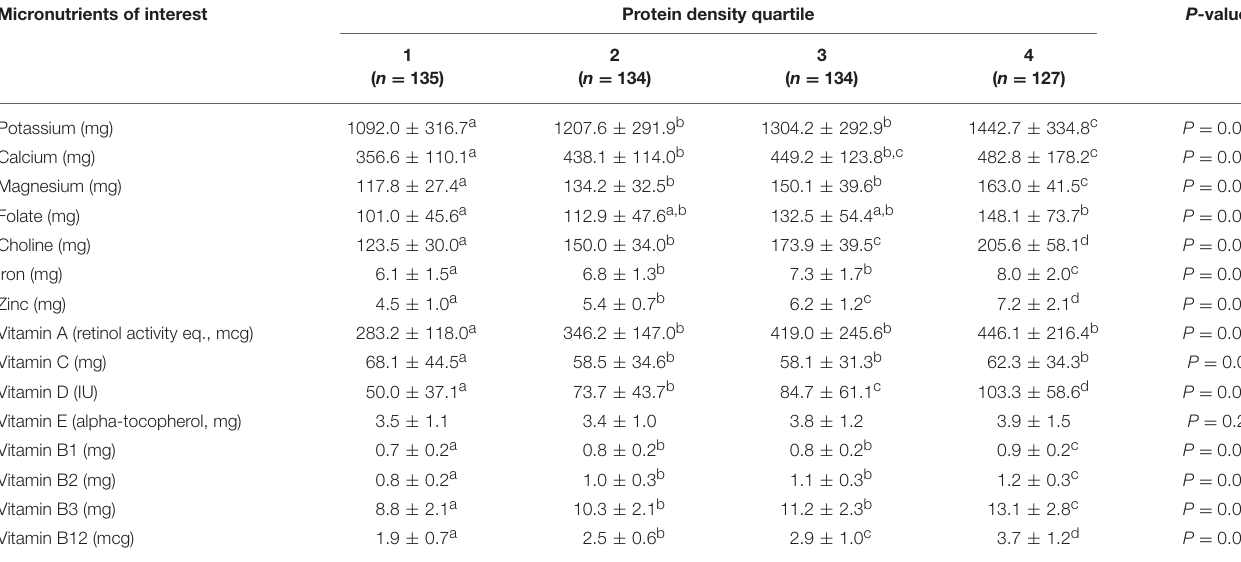
TABLE 5 | Estimated daily micronutrient intakes across protein density quartile when adjusted for fruit and vegetable intake in healthy young adults 1, 2 . Micronutrients of